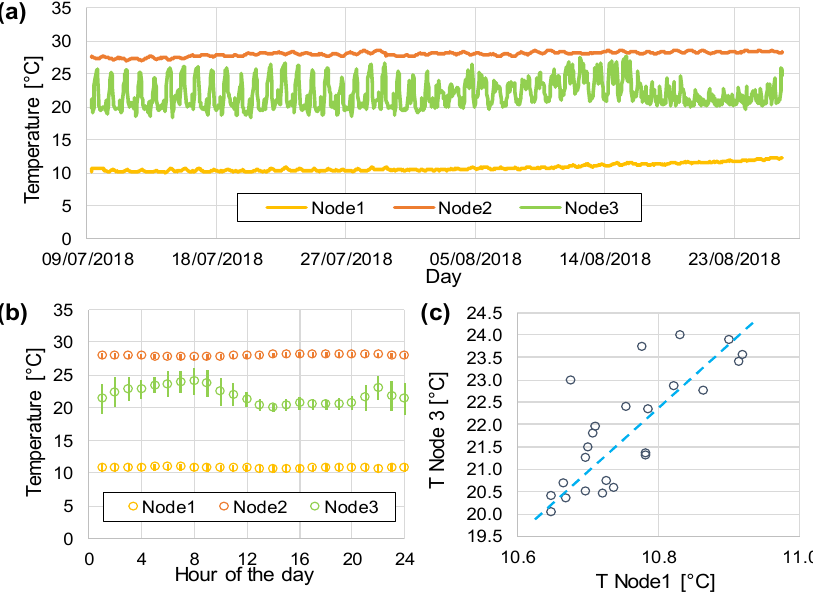
Figure 9. Temperature values recorded for the three nodes for 50 days ( a ), and elaboration, showing daily variations ( b ) and correlation ( c ) between Node 1 and 3.